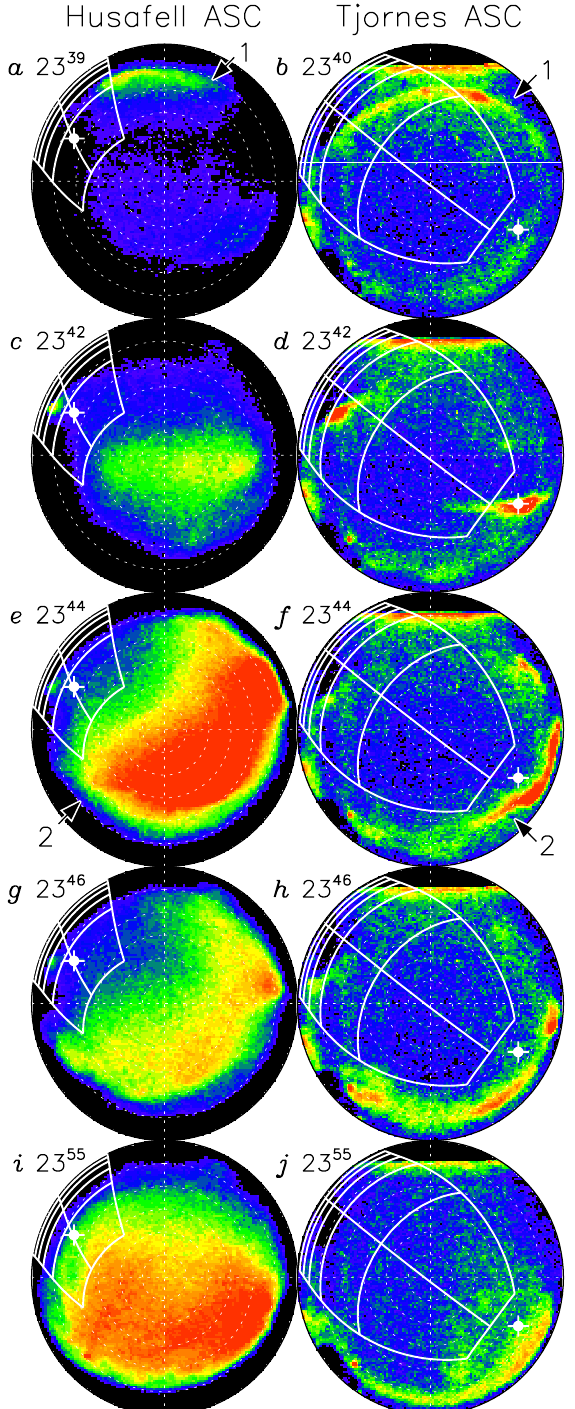
Fig. 2. False-colour all-sky camera images from Husafell and Tjörnes for five times from the interval of study. Red regions are those of greatest intensity. The images are aligned such that geo- magnetic North and West are directed towards the top and right of each panel. Auroral features 1 and 2 are indicated by arrows. The location of the radar field-of-view (the same grid system presented in Fig. 1) is indicated in each image, along with the location of the zenith of the other all-sky camera; this projection assumes an emission altitude of 110